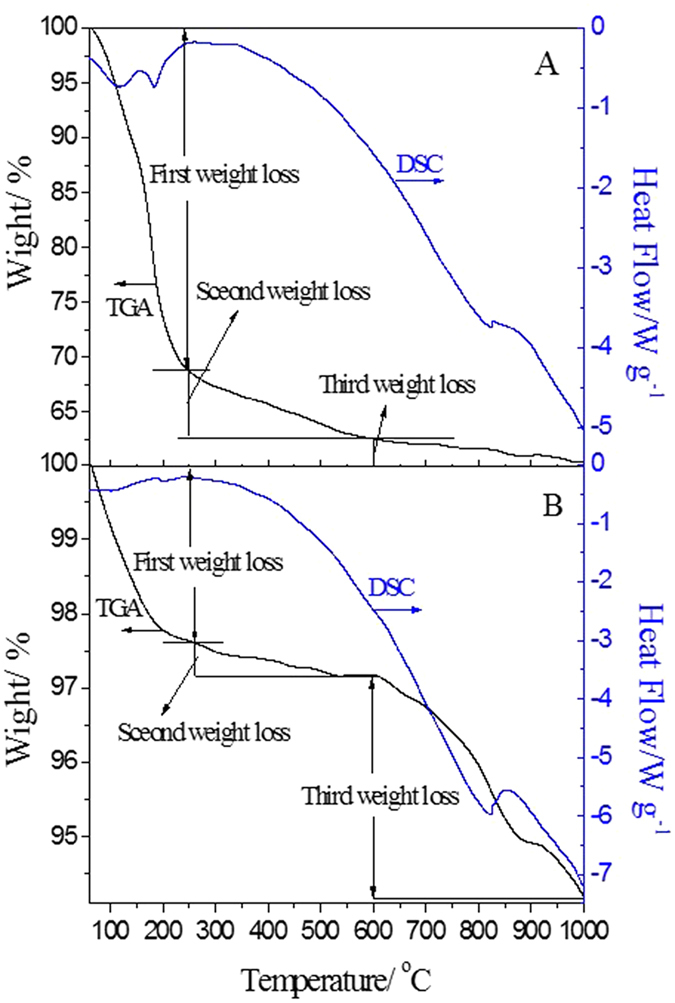
TG-DSC curves of K-OMS-2/SiO2-50.(A) none calcined, (B) calcined.